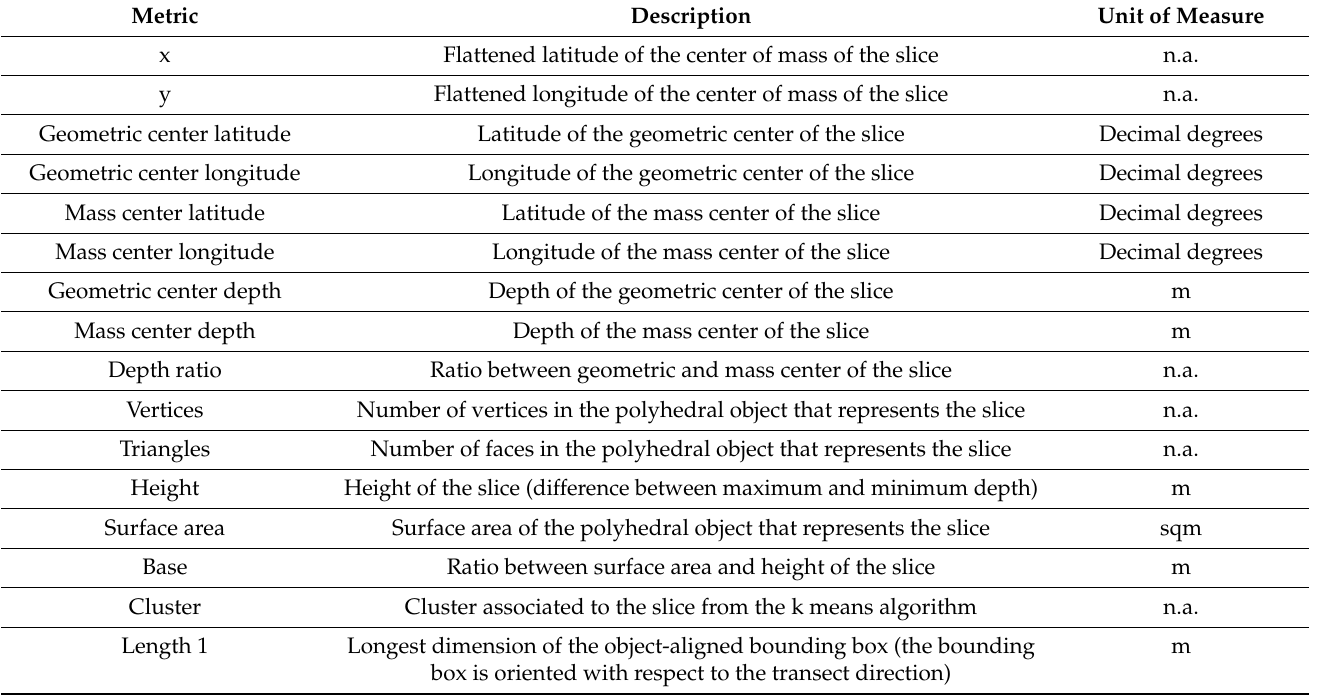
Table 2. Descriptions and units of the 24 metrics used for target